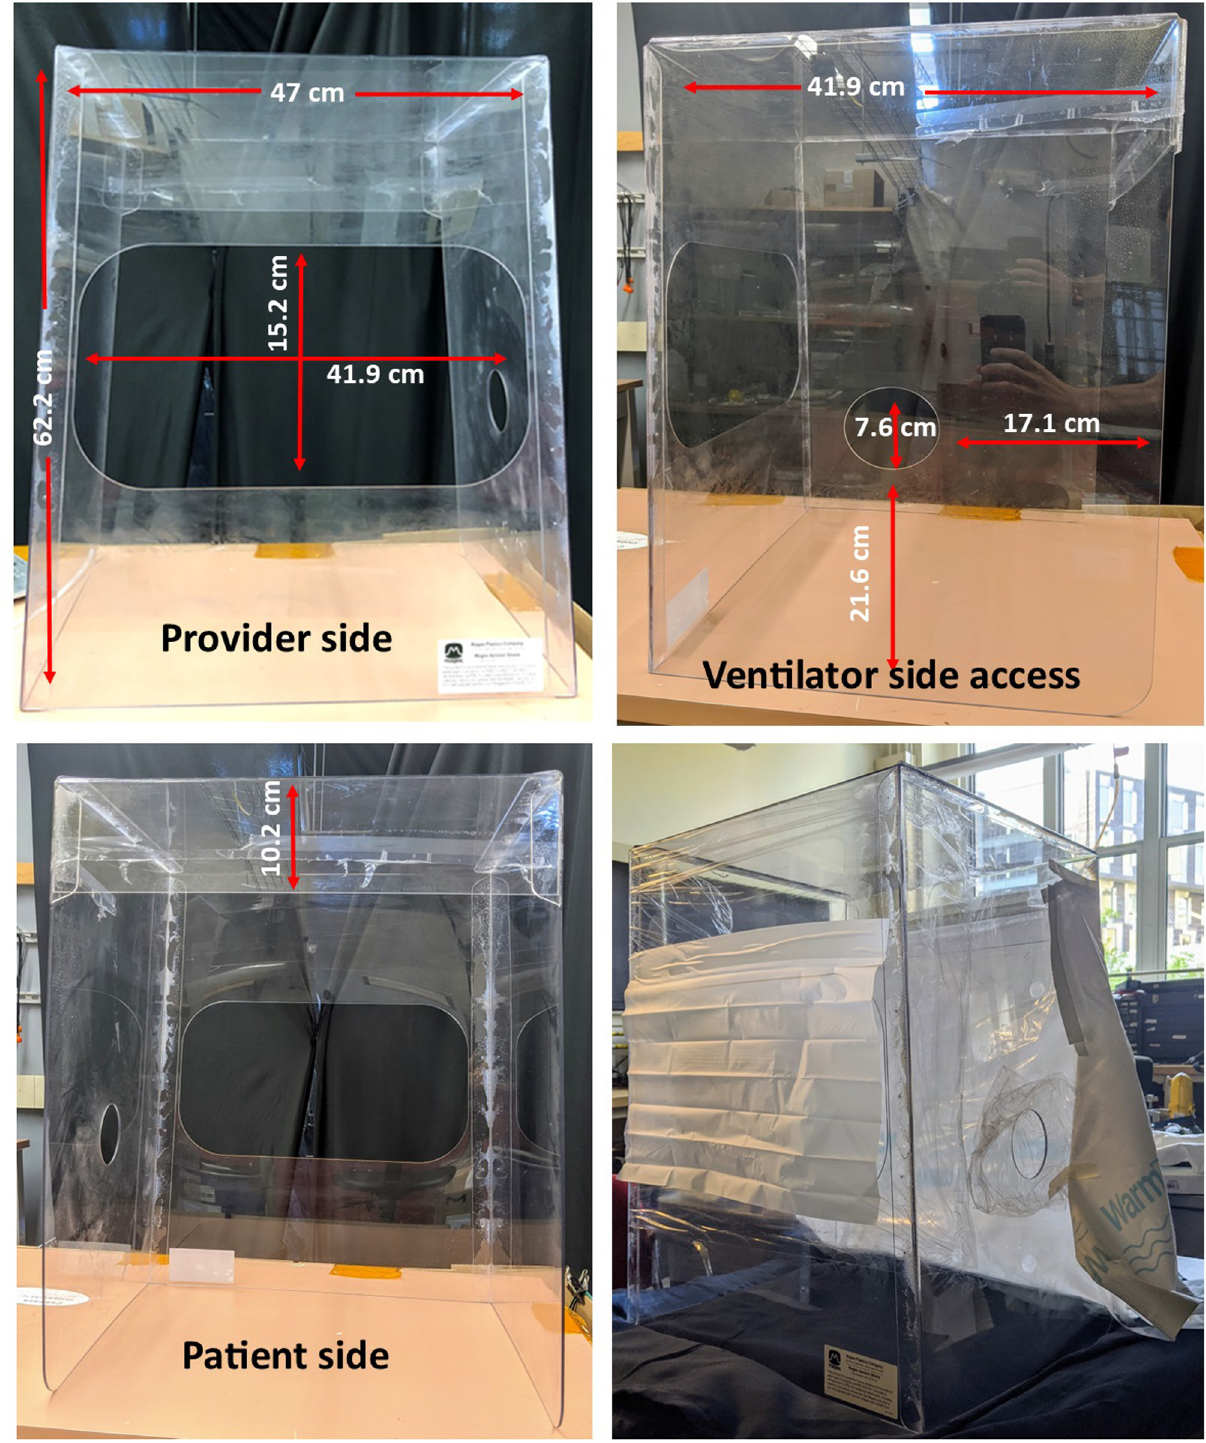
Fig 1. Design and dimensions of the enclosure: A schematic of the enclosure showing the three cutout openings. One on the cephalad (provider) side to provide access for the healthcare worker’s hands, a second on the caudal (patient) side to allow room for the patient’s torso, and a third on the lateral side to enable ventilator and other tubing access. The provider access cutout is large to maximize mobility.